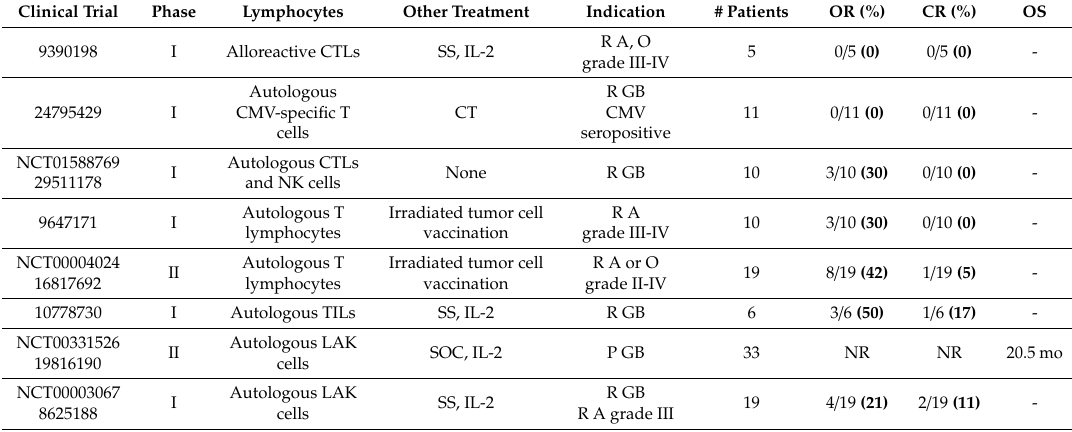
Table 5. Phase I / II clinical trials with non-gene engineered T cells and other lymphocytes in glioblastoma. Clinical